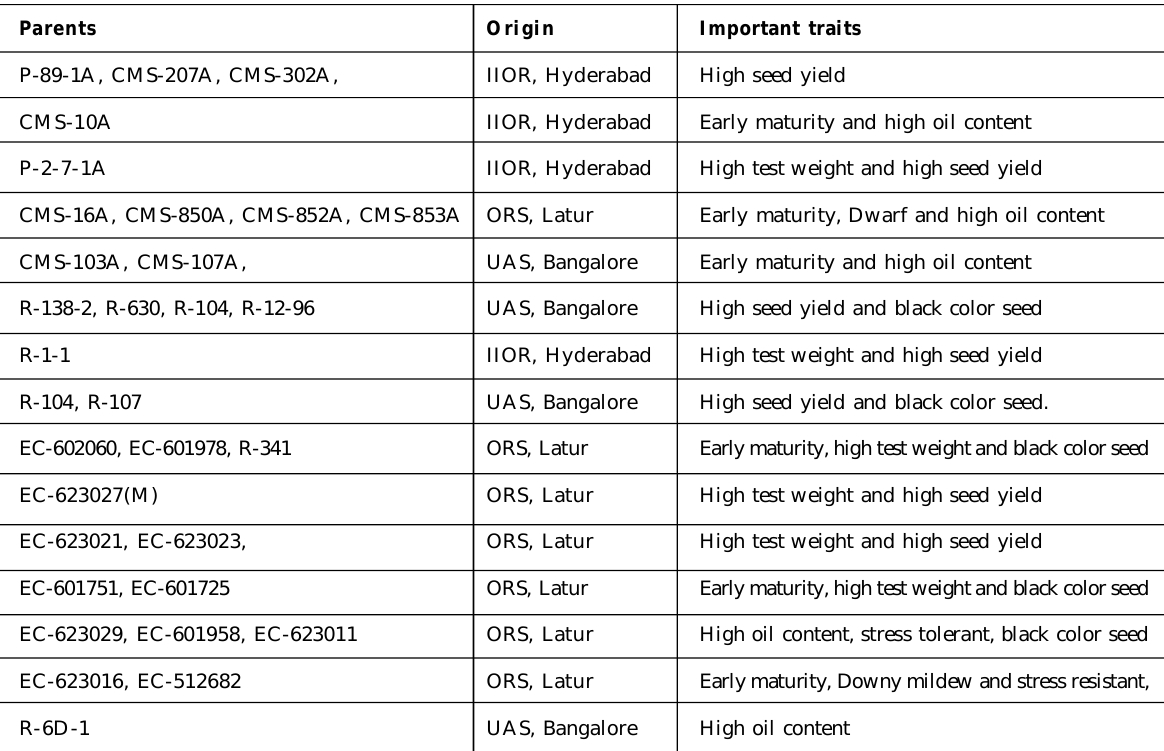
Table 1: List of genetic materials used in experiment Parents Origin Important